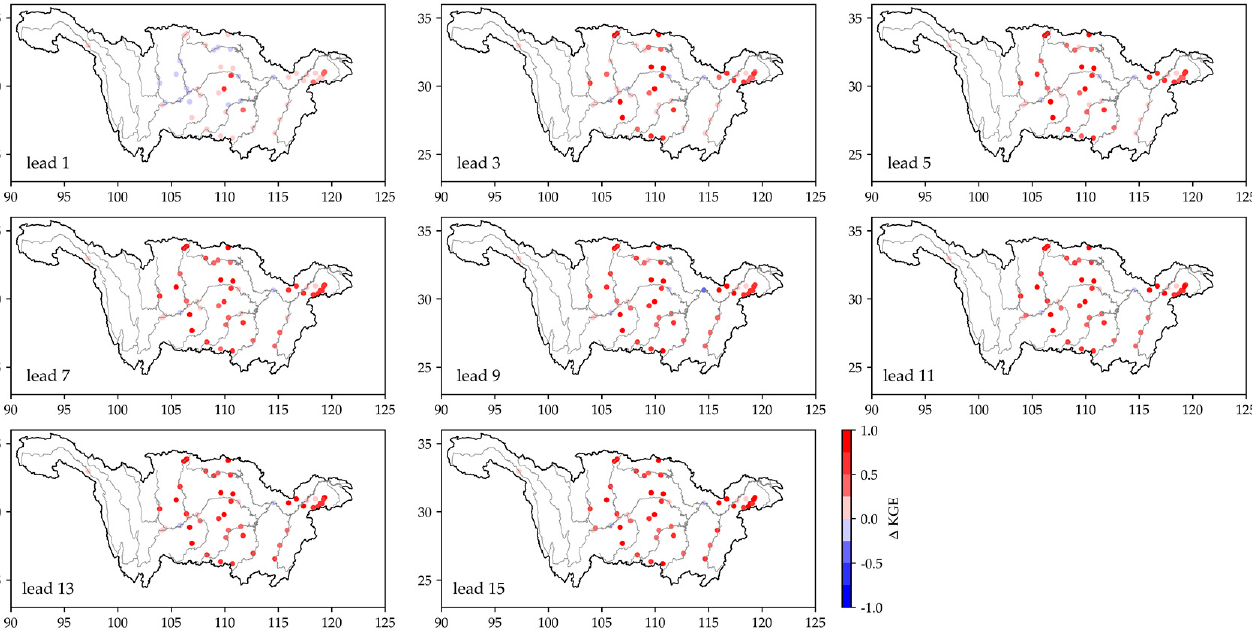
Figure 11. The relationship between the difference of streamflow forecast performance ( ∆ KGE of the cascade LSTM model with prefect precipitation and the default LSTM model ) and the water- shed area (ln km 2 ) at the lead times of 1–15 days.